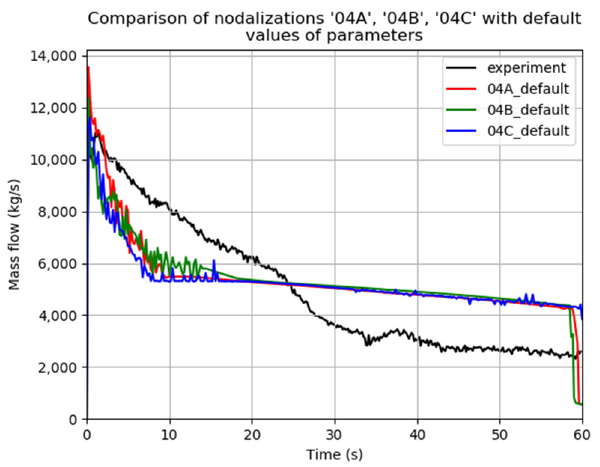
Figure 4. Mass flow rate for the models with 4 CV 04A, 04B, and 04C nodalizations compared with the experimental data.